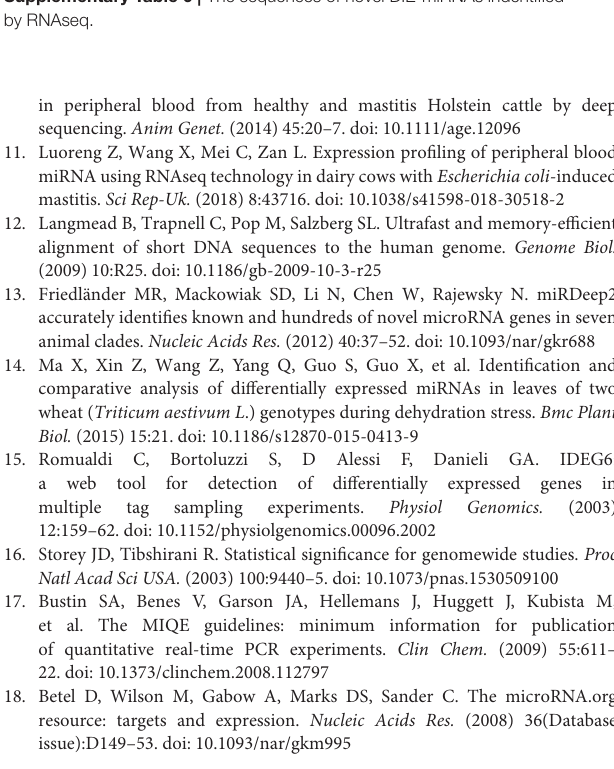
Supplementary Table 5 | The list of known DIE-miRNAs indentified by RNAseq. Supplementary Table 6 | The sequences of novel DIE-miRNAs indentified by